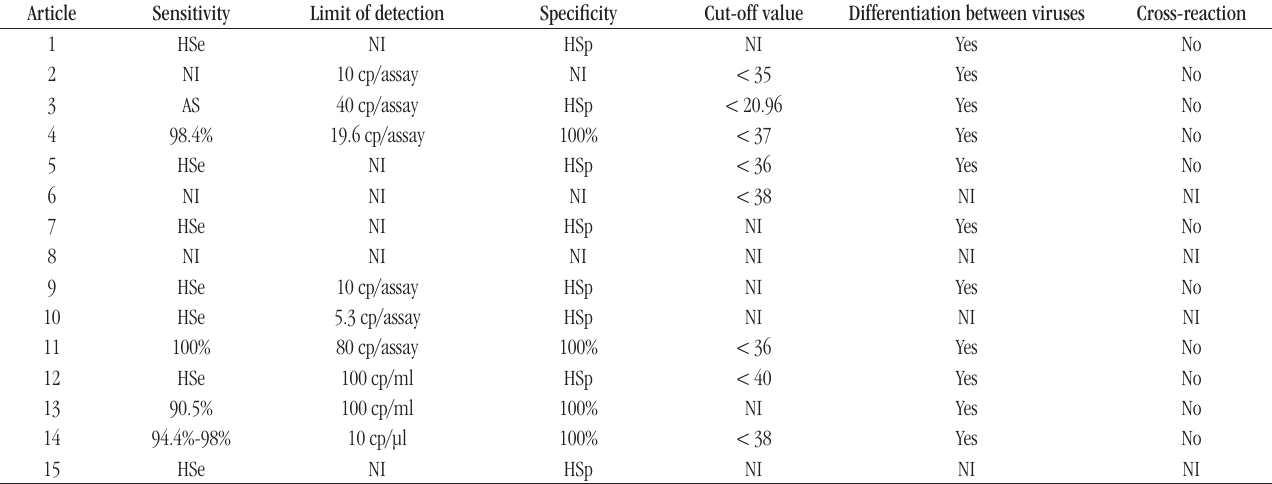
TABLE 3 – Effectiveness of real-time PCR assays performed on articles selected in the integrative